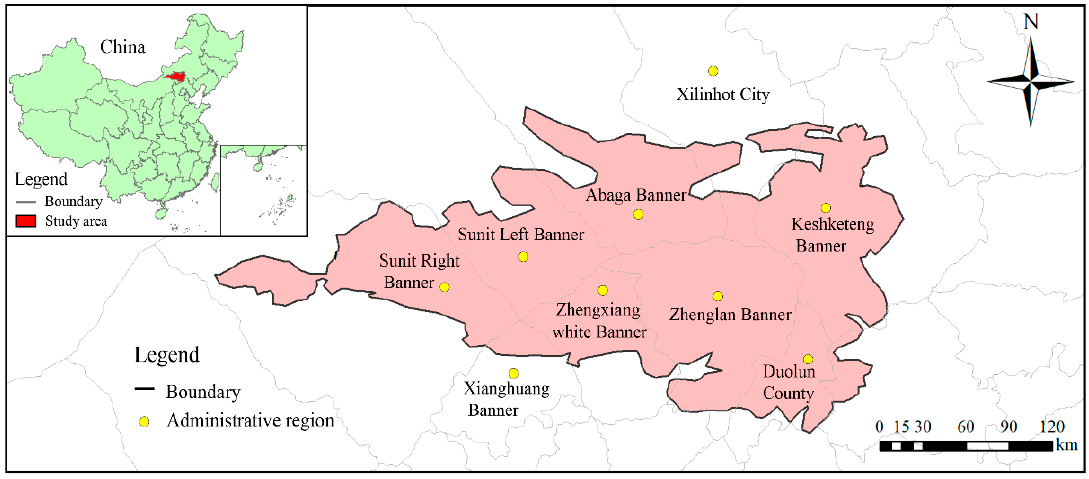
Figure 2. Study area .